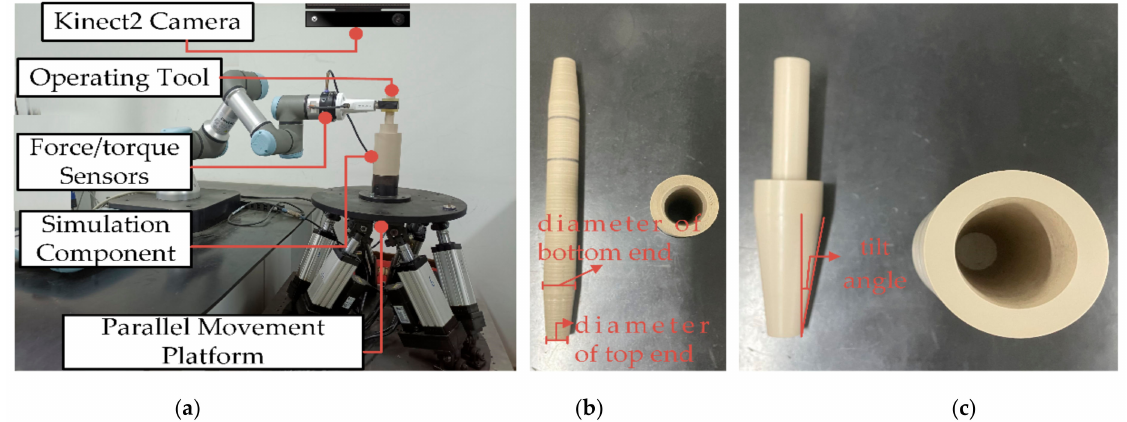
Figure 15. Experimental equipment. ( a ) Experimental equipment, ( b ) Operation tool 1 and operation object 1, ( c ) Operation tool 2 and operation object